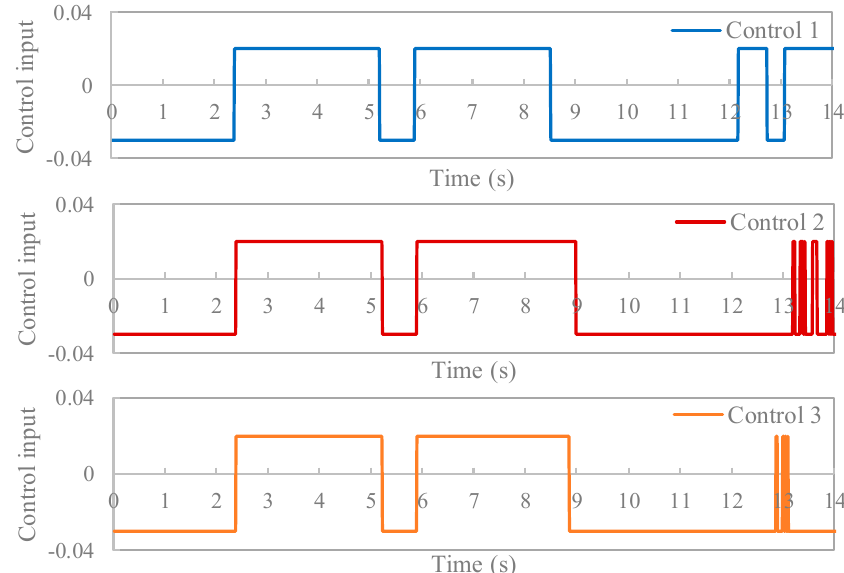
Figure 23. Time history of the control input (controls 1 through 3).